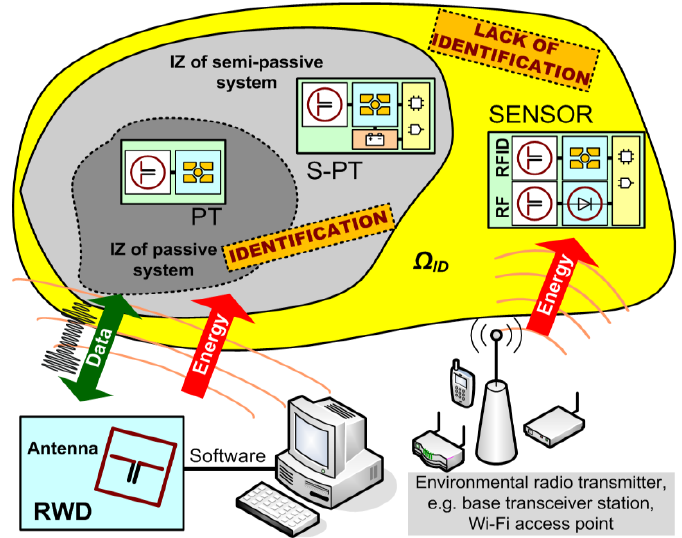
Figure 1. Block diagram of RadioFrequency Identification (RFID) system with autonomous RFID